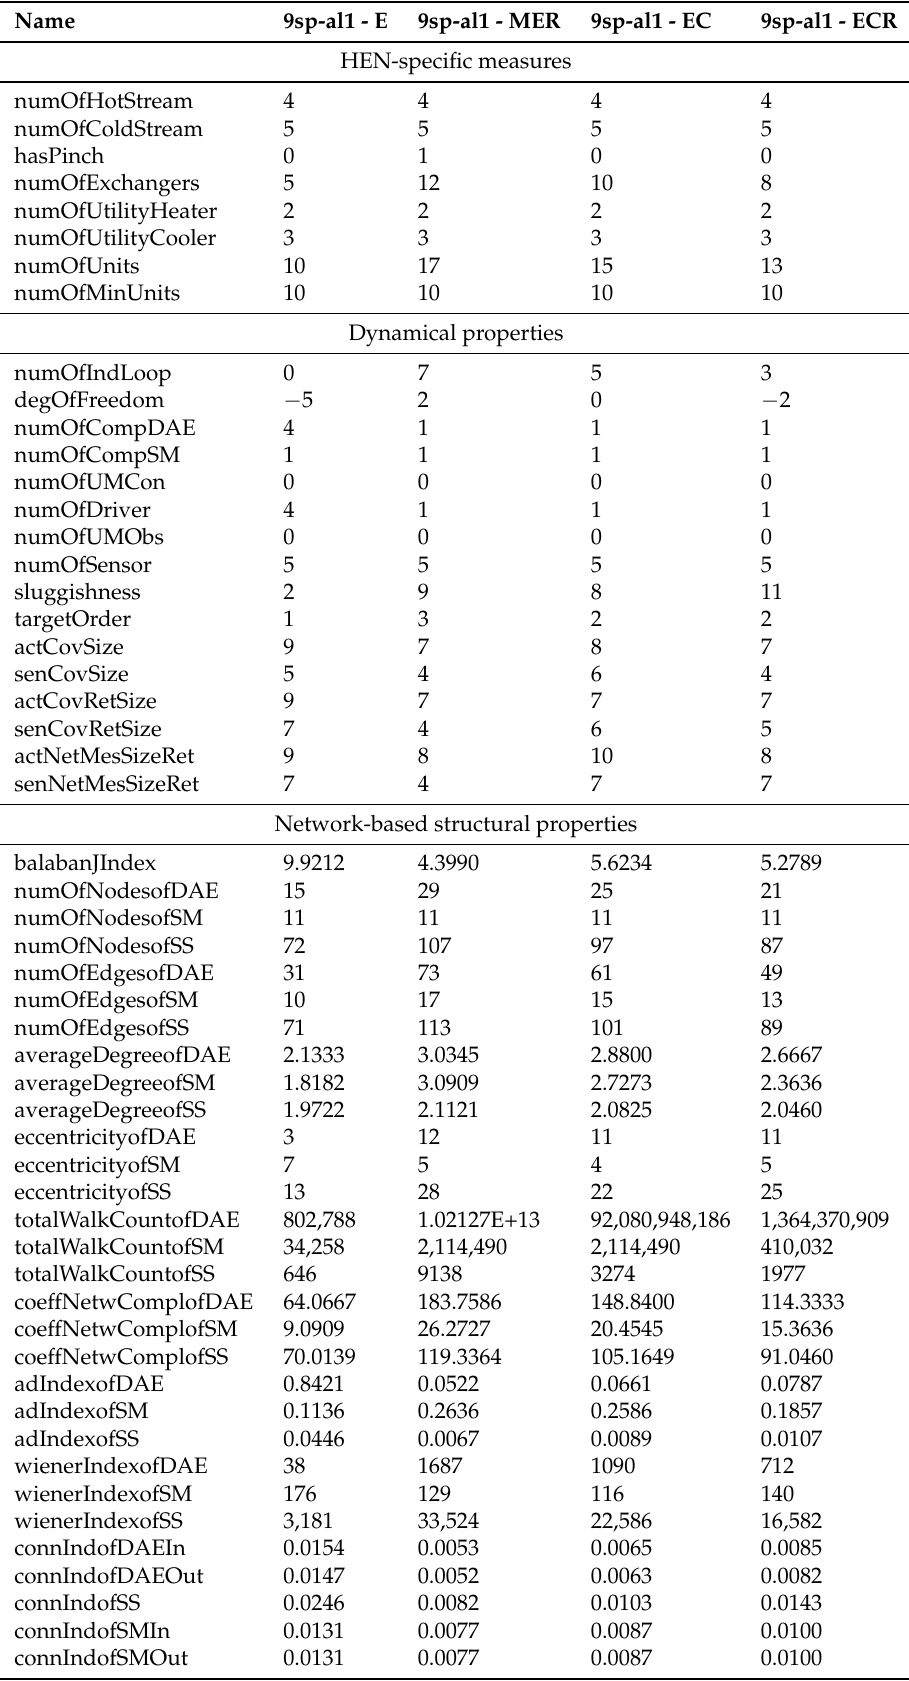
Table 6. Calculated measures and their short